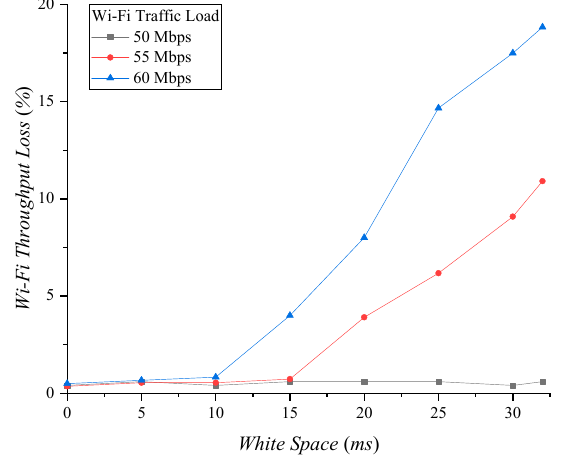
Figure 10. Wi-Fi throughput loss according to white space.